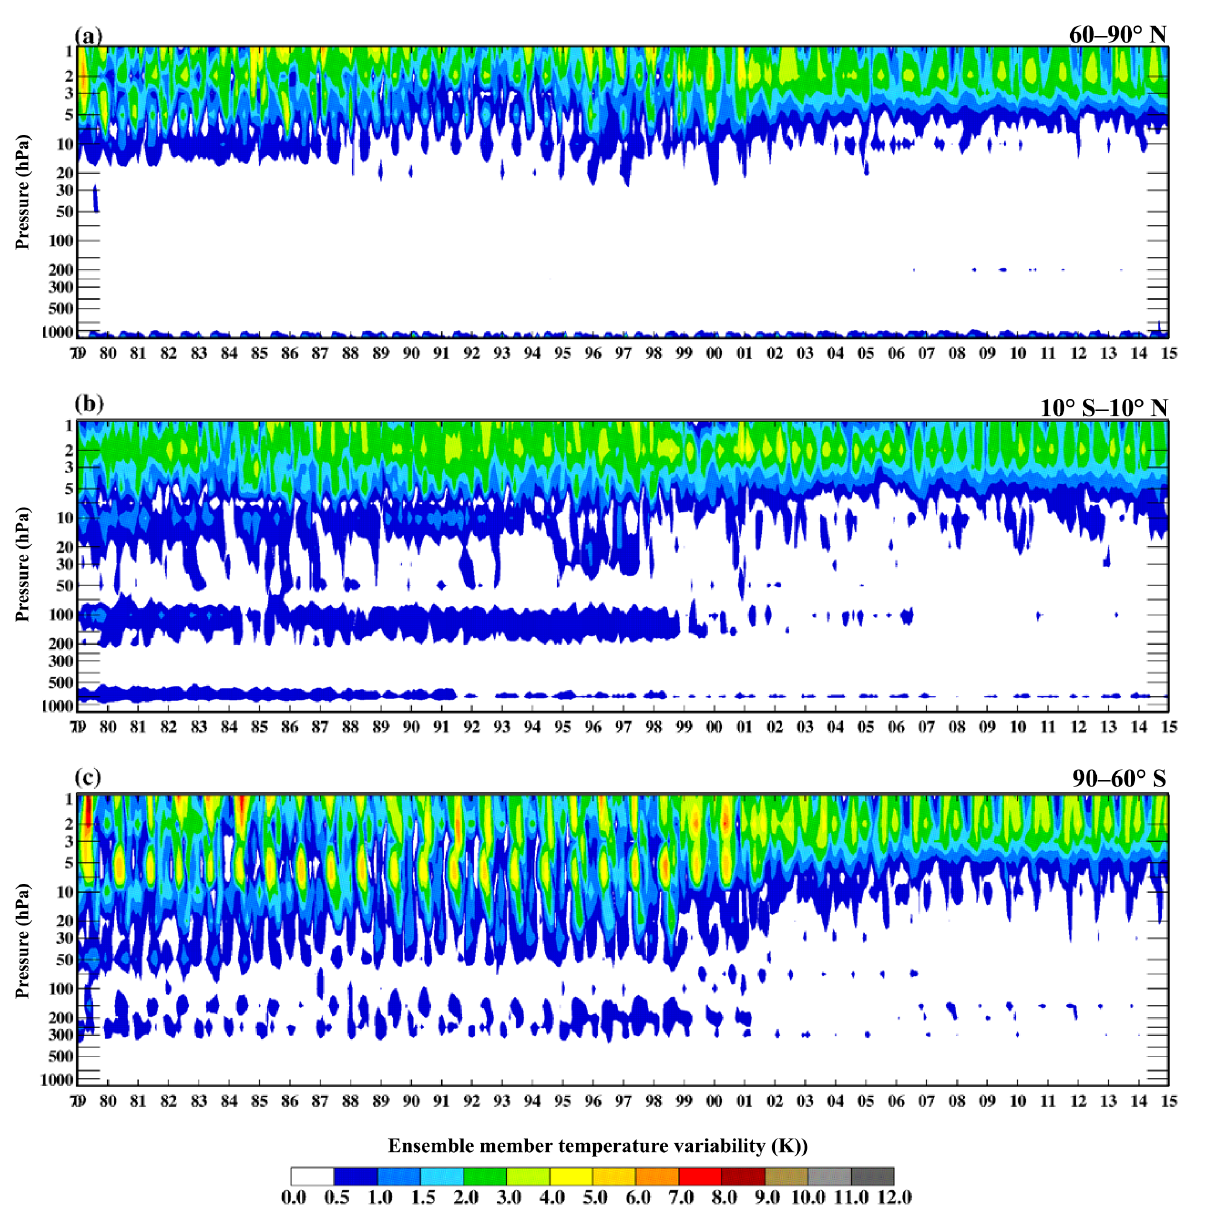
Figure 4. Pressure vs. time plots of the temperature SD (K) for each month of the three reanalyses making up the REM for three zonal regions: 60–90 ◦ N (a) , 10 ◦ S–10 ◦ N (b) , and 90–60 ◦ S (c)